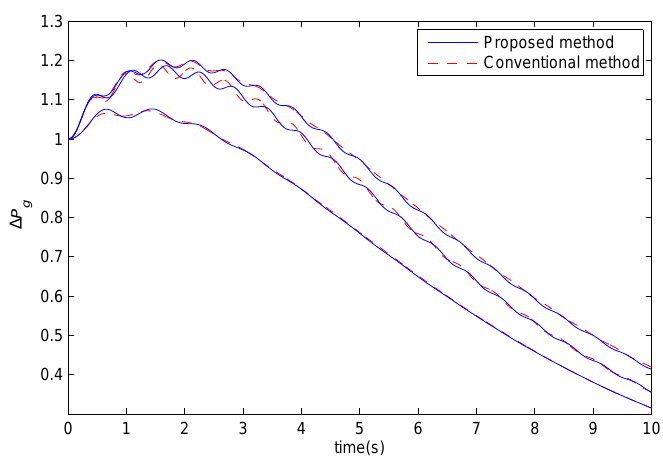
Figure 9. The power output deviation of the gas turbine generator P g